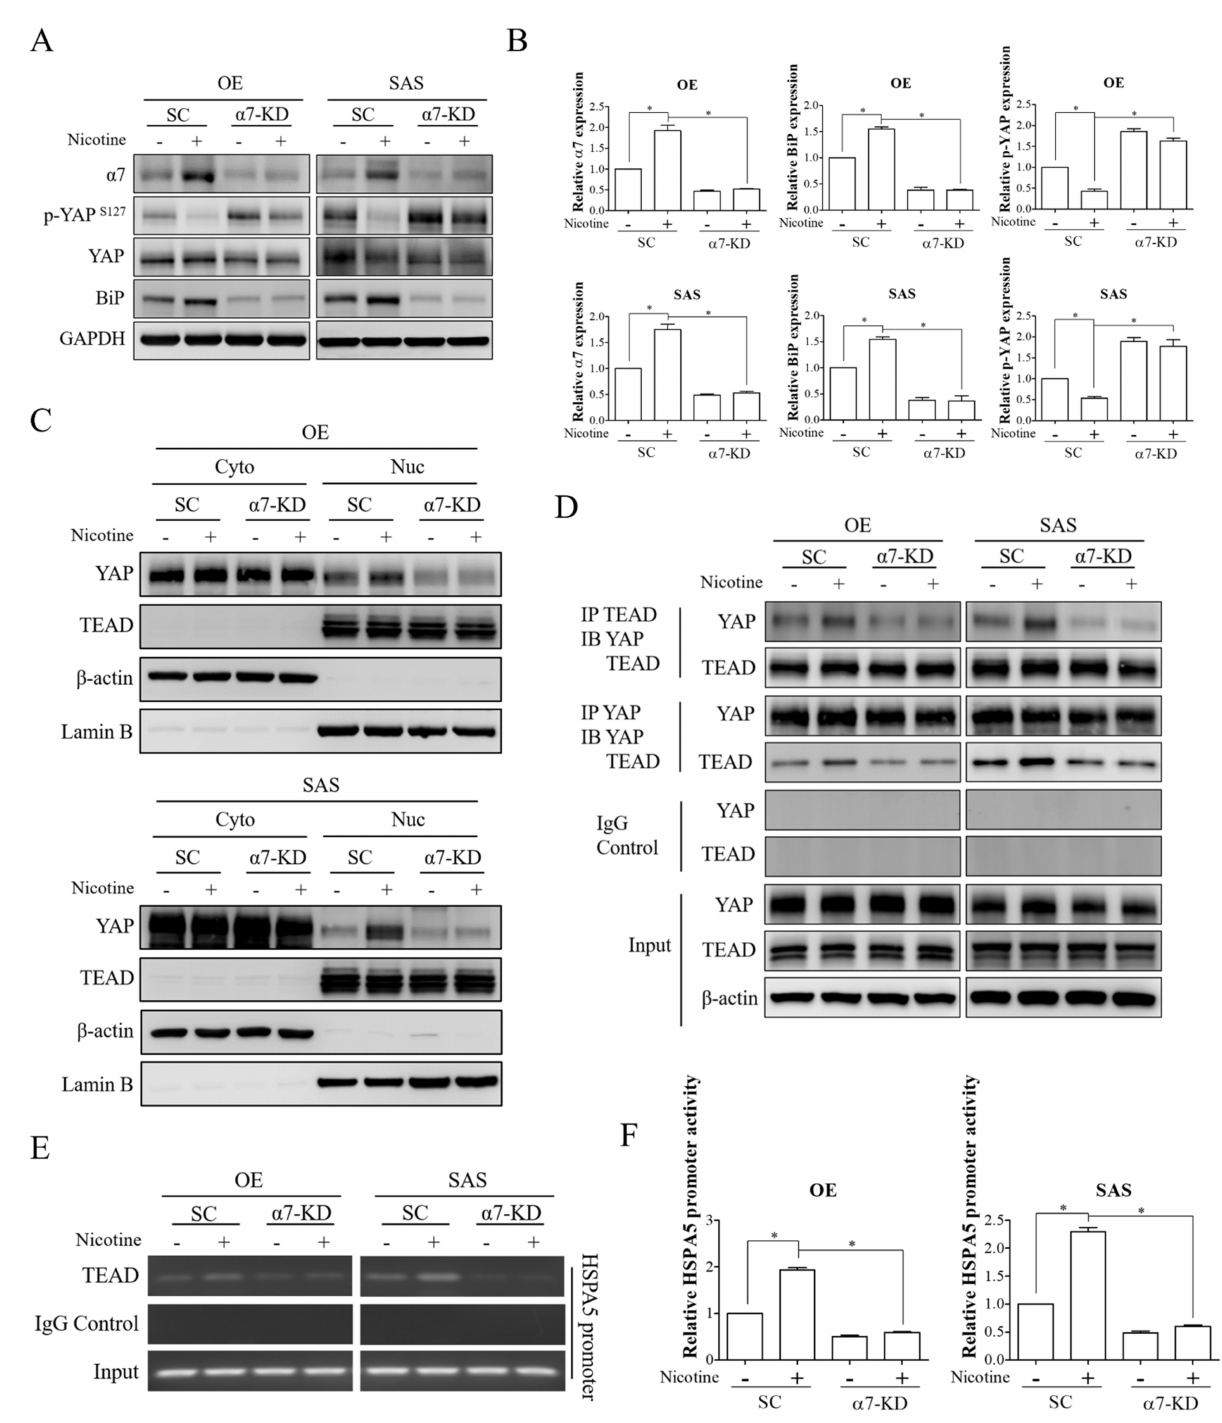
Figure 4. α 7-nAChR-Akt signaling increased YAP activation, DNA binding, and transactivation abilities of the YAP-TEAD complex upon nicotine exposure. OE and SAS cells transfected with either non-targeting siRNA or α 7-nAChR siRNA